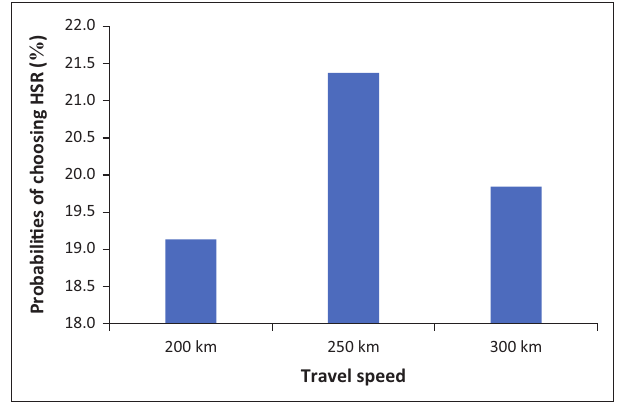
FIGURE 7: Probability of choosing high-speed rail based on speed.